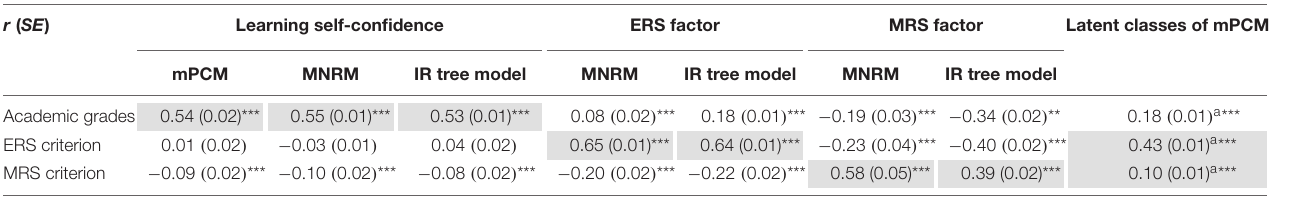
TABLE 6 | Relationships of criteria with the factors of the IRT models in Study